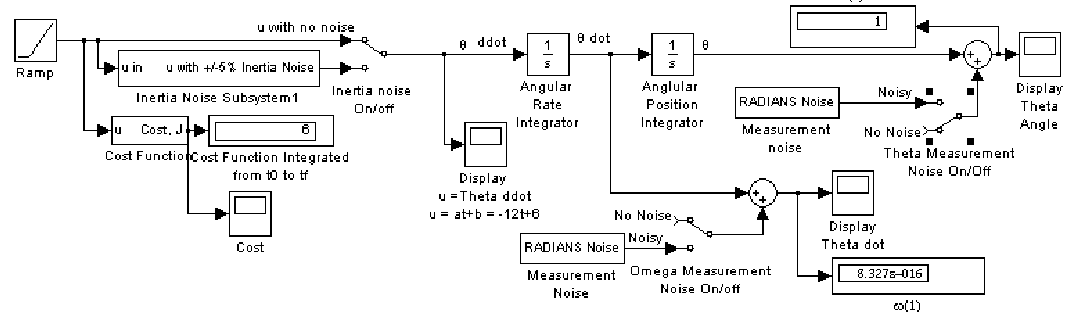
Figure 1. External states, co ‐ states, and control for optimally controlled double integrator plant with time on the abscissa and values on the ordinate. ( a ) State trajectories, θ (t) and ω (t) from Equations (18)–(20). ( b ) Co ‐ state trajectories in shadow space λ _ θ (t) , λ _ ω (t) , and control u(t) solutions to Equations (12)–(15), and (17).